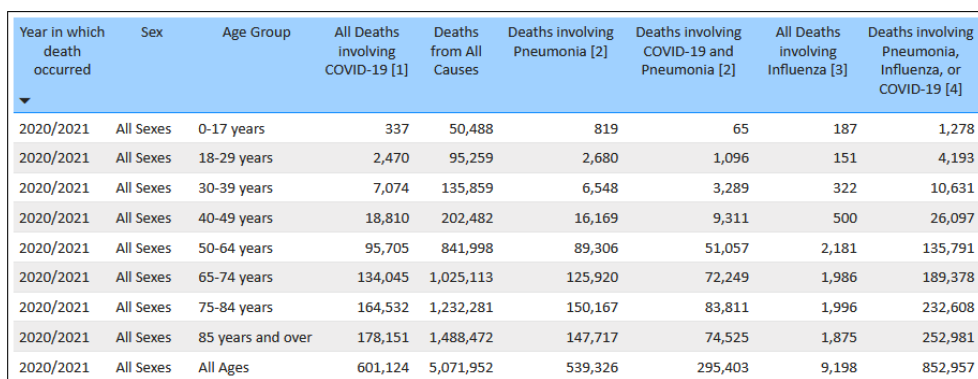
Figure A1. COVID-19 cases and deaths statistics [WHO, 22 July 2021].